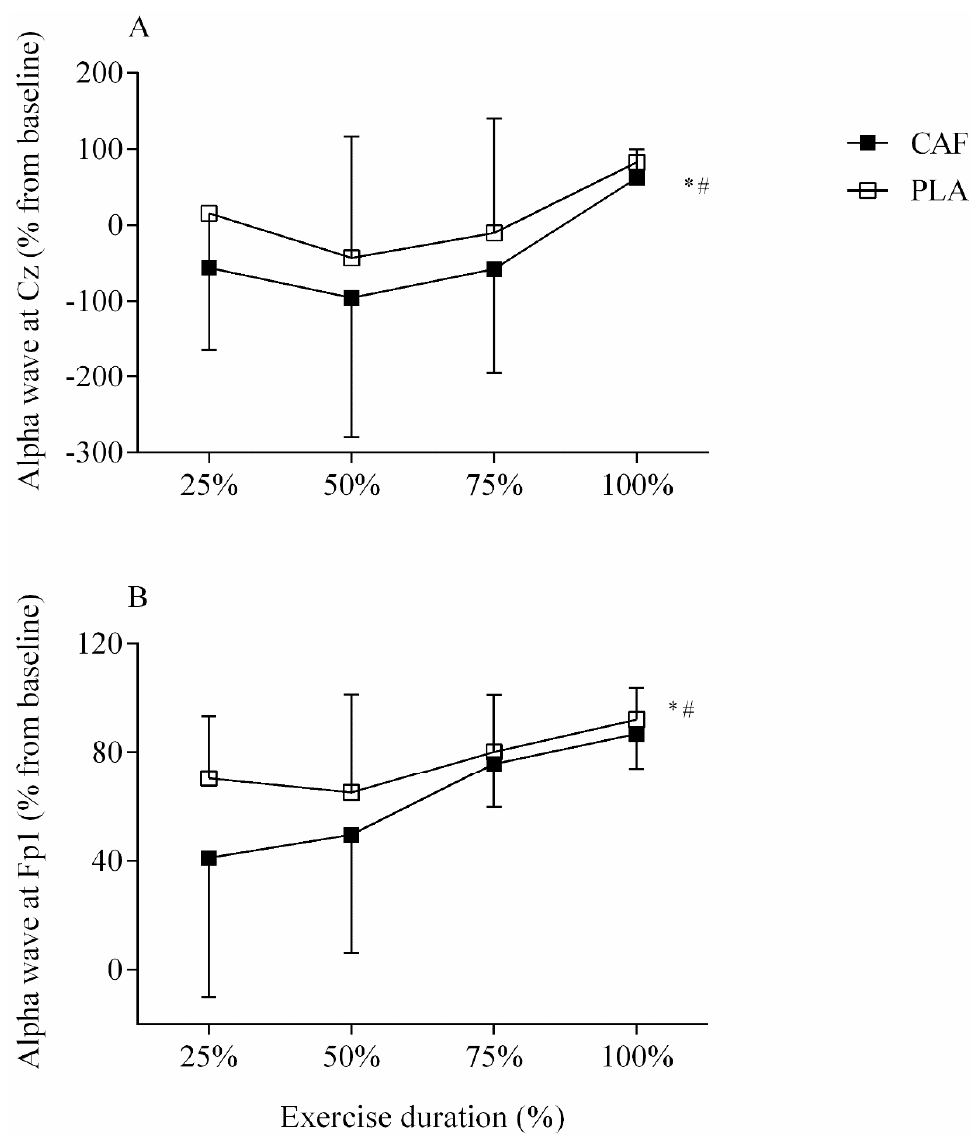
Figure 2. Electroencephalography (EEG) alpha wave recorded at Cz ( A ) and Fp1 ( B ) positions during isometric contraction in CAF (filled square) and PLA (open square) sessions. * Indicates condition main effect in Cz ( p = 0.027) and PFC ( p = 0.045). # indicates moment main effect in Cz ( p = 0.000) and Fp1 ( p = 0.001). Data are reported as mean ± SD.